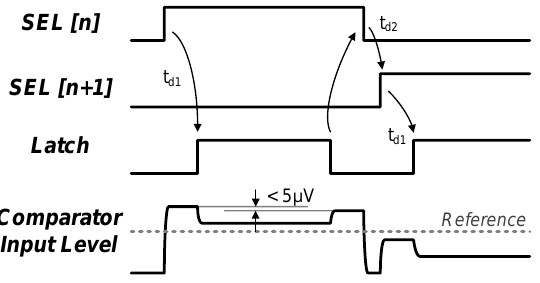
Figure 9. Interference-tolerant reset signal generated by the combination of the time-delay based control units.